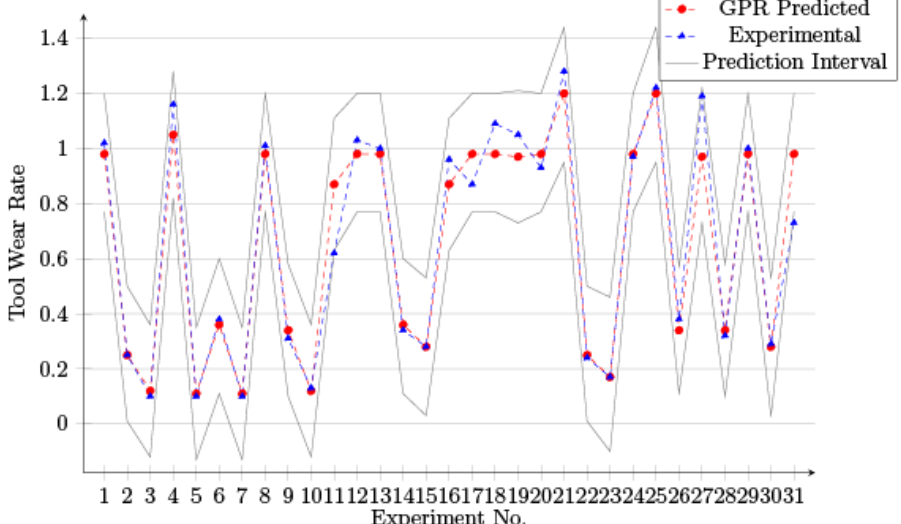
Figure 13. Experimental and GPR predicted values for TWR training data.